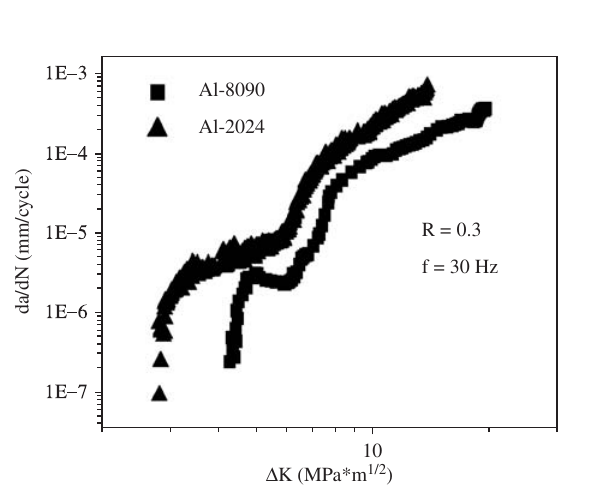
Figure 4. Variation of fatigue crack growth rate with stress-intensity-factor range.